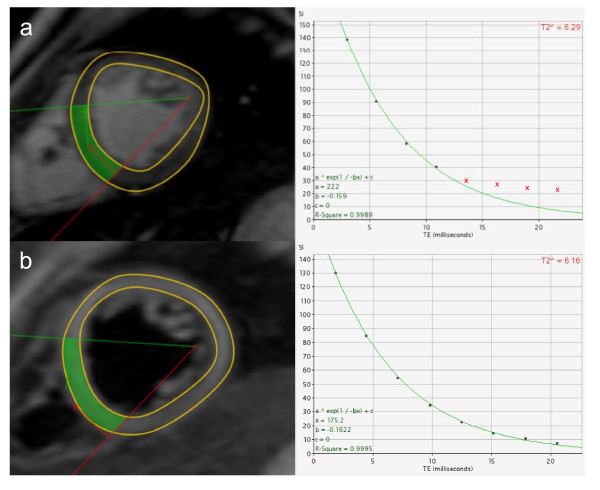
Signal decay is rapid in heavily iron loaded hearts causing the curve to plateau for the longer echo times. The upper frame shows how later points that fall below background noise level are removed to improve curve fit (red crosses) using the truncation method (R2= 0.9989 with truncation). For the black blood acquisition (b) background noise is reduced thus the curve fit is good for the full range of echo times without truncation (R2 = 0.9995) which reduces the likelihood of analysis errors.